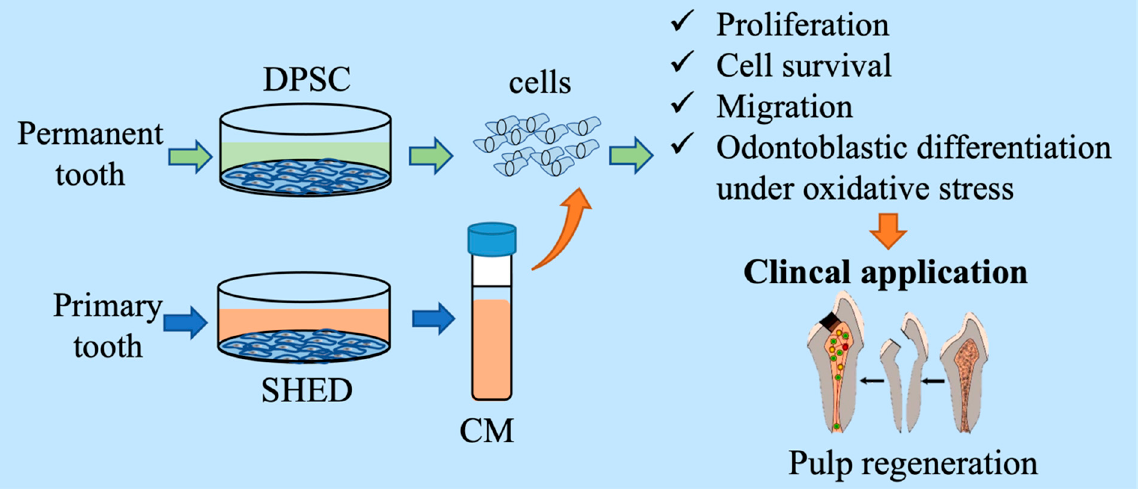
Figure 1. Graphic abstract. SHED were collected from the pulp tissue of primary teeth, and DPSC were collected from the pulp tissue of permanent teeth. The cytokines/growth factors contained in SHED-cultured conditioned media promoted DPSC proliferation, survival, migration, and cell differentiation in pulp regenerative therapy.